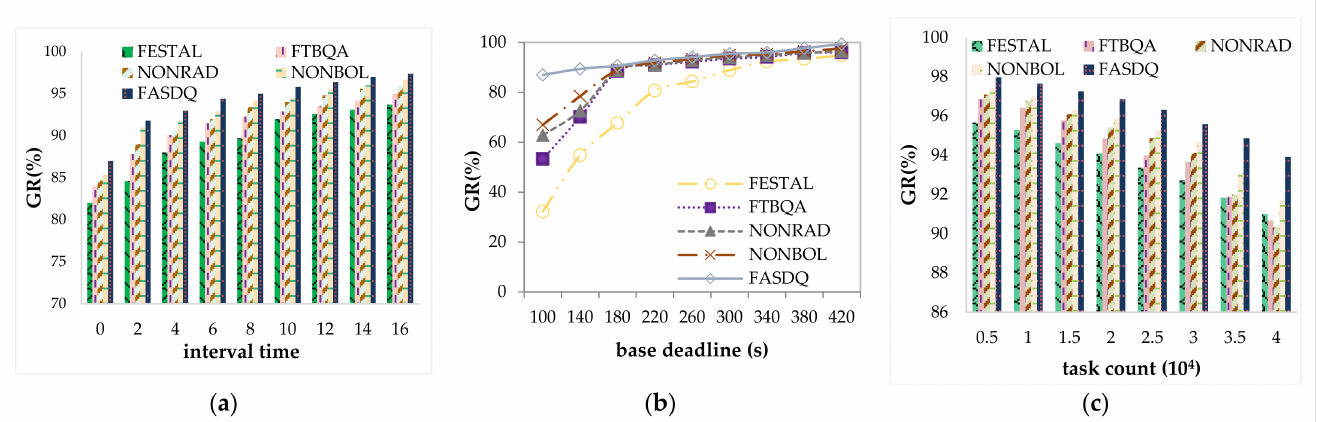
Figure 8. Comparison of guarantee rate (GR). ( a ) Impact of interval time on GR; ( b ) impact of base deadlines on GR; ( c ) impact of task count on